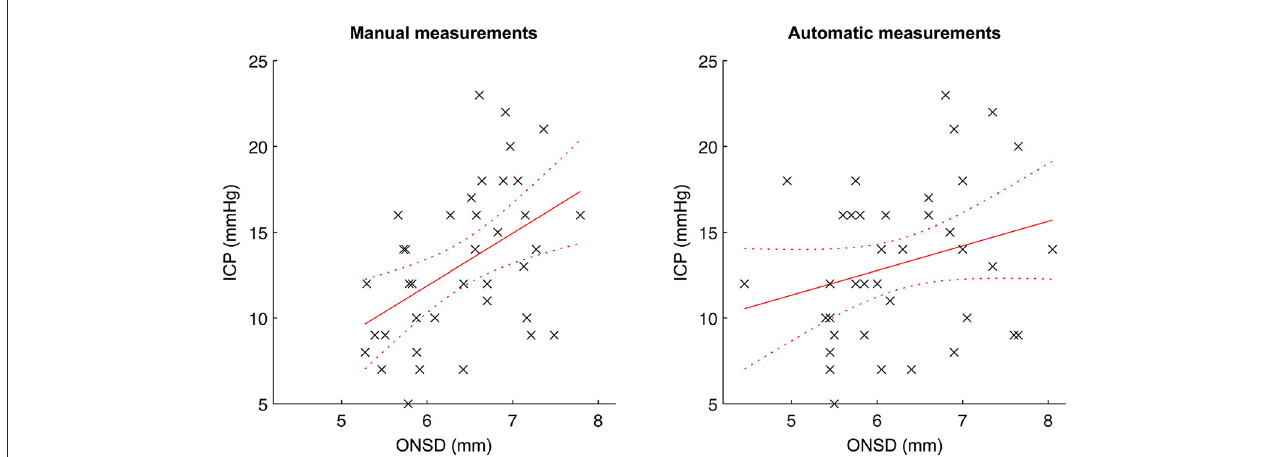
FIGURE3 Correlation between automatically/manually measured optic nerve sheath diameters and ICP. Scatterplots with linear regression lines and associated confidence bounds for manual ONSD measurements (left) and automatic ONSD measurements (right) .